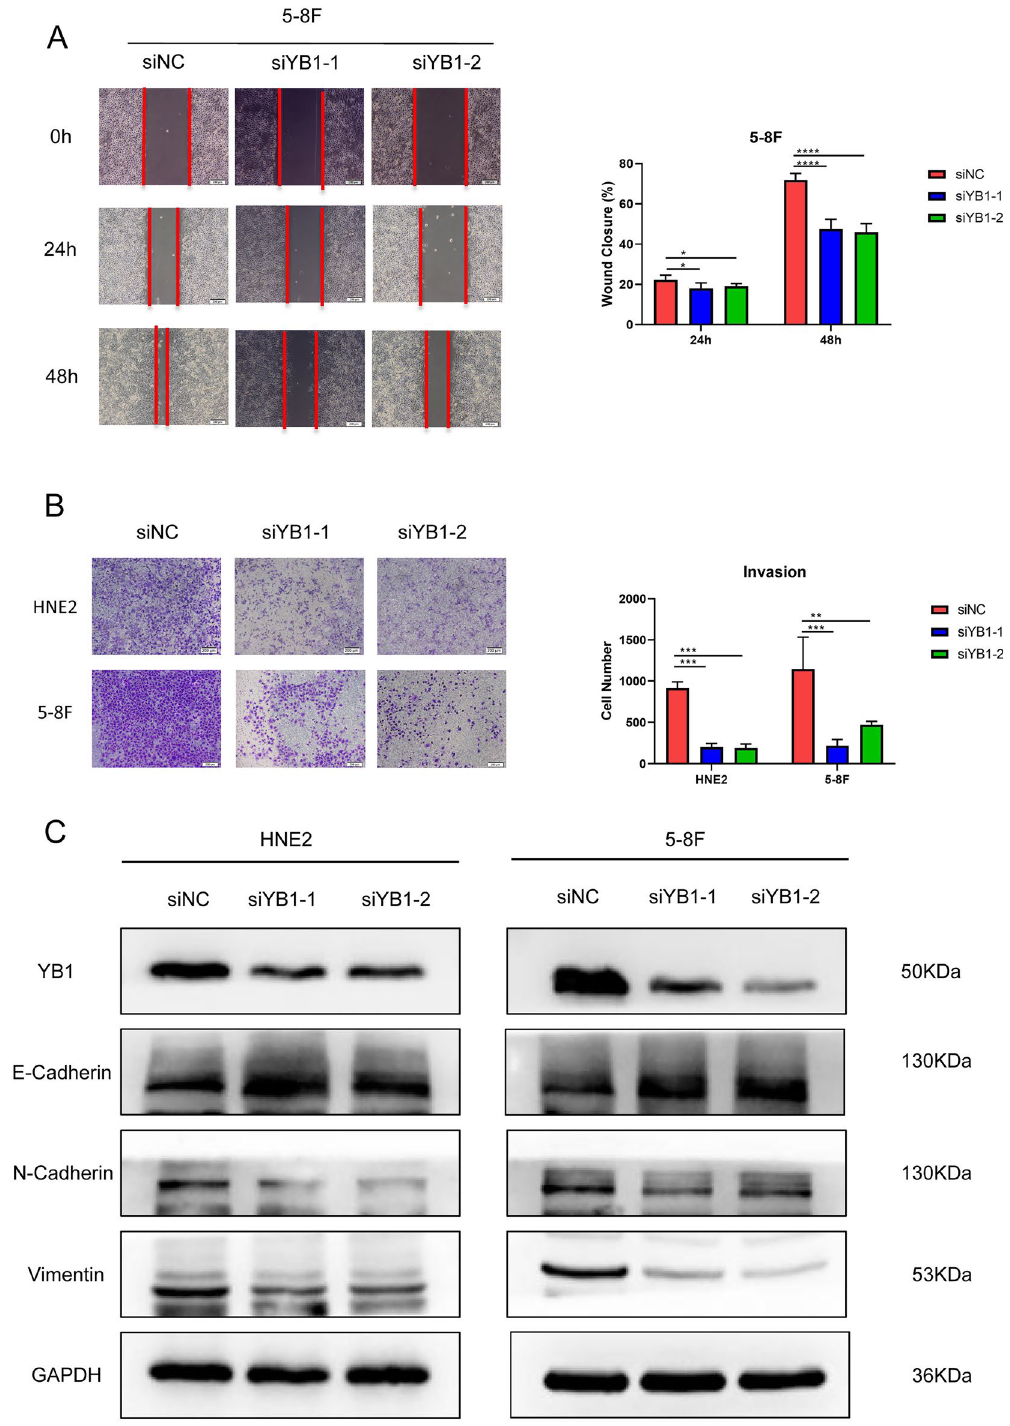
Figure 4. Knock down of YB1 inhibited NPC cell migration and invasion in vitro. ( A ) 5-8F cells with YB1 knock-down showed significantly lower migration rates in wound healing assay; ( B ) HNE2 and 5-8F cells with YB1 knock-down showed significantly lower invasion rates in matrigel invasion assay when compared with control cells. ( C ) Knocking down YB1 upregulated expression of E-Cadherin and downregulated expression of N-Cadherin and